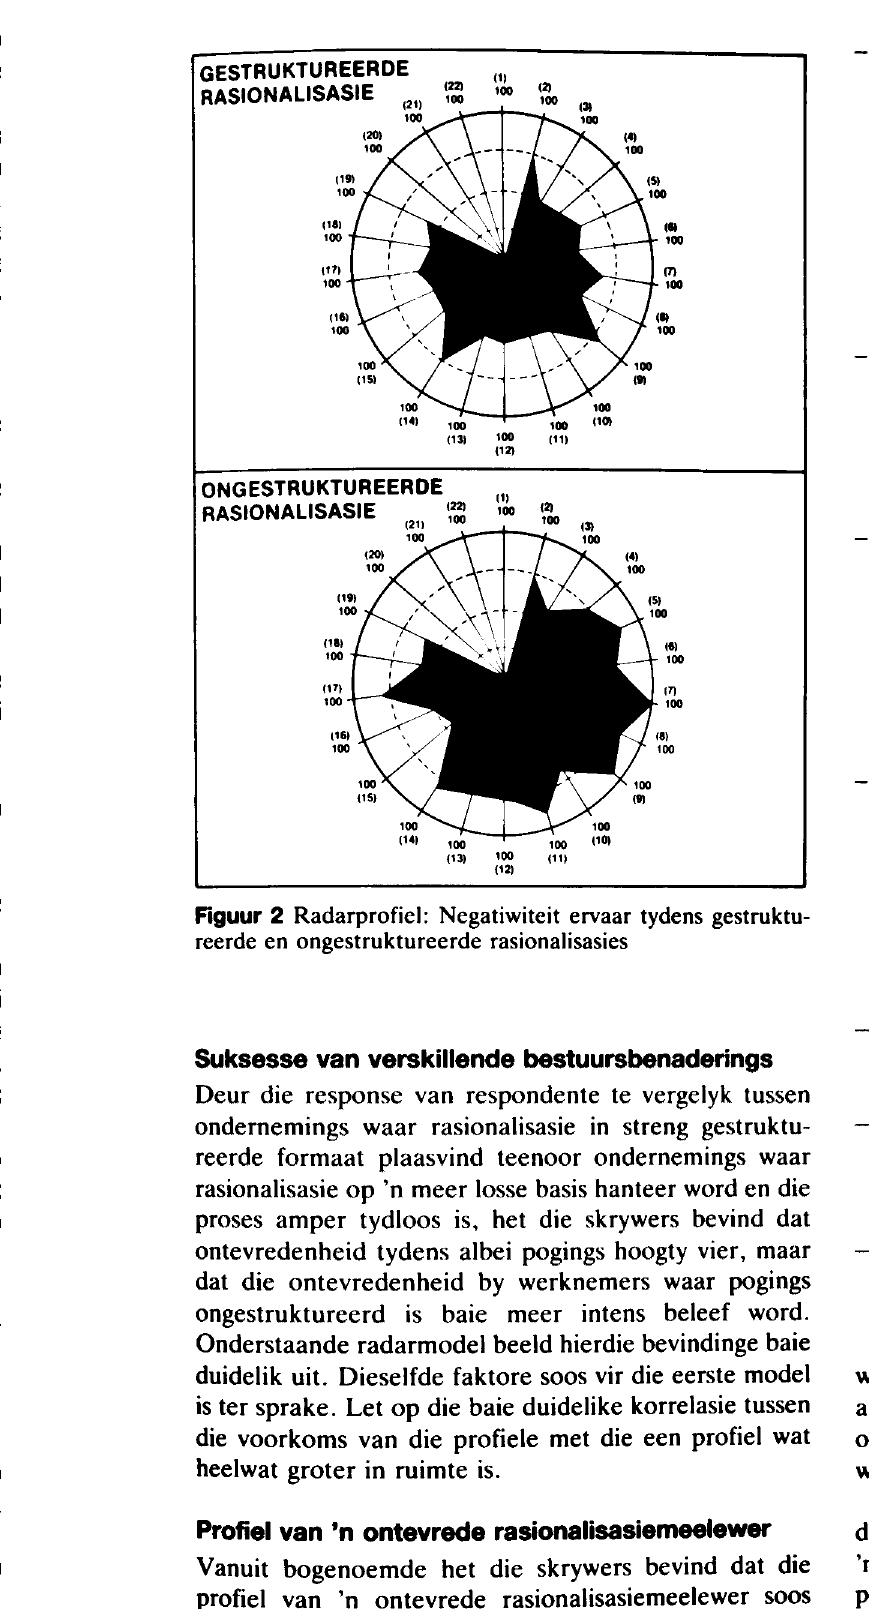
Suksesse van verskillende bestuursbenaderings Deur die response van respondente te vergelyk tussen ondememings waar rasionalisasie in streng gestruktu reerde formaat plaasvind teenoor ondememings waar rasionalisasie op 'n meer losse basis hanteer word en die proses amper tydloos is, het die skrywers bevind dat ontevredenheid tydens albei pogings hoogty vier, maar dat die ontevredenheid by werknemers waar pogings ongestruktureerd is baie meer intens beleef word. Onderstaande radarmodel beeld hierdie bevindinge baie duidelik uit. Dieselfde faktore soos vir die eerste